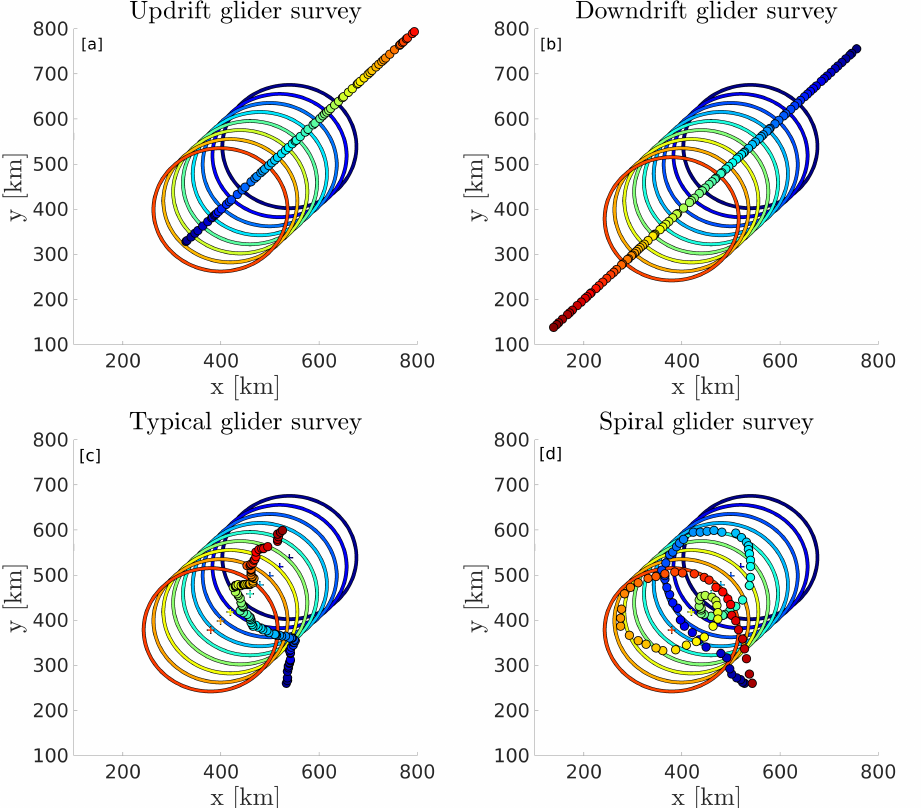
Figure 5. Successive positions of the drifting eddy’s edge (contours) superimposed on the simulated glider tracks (dots). Time is color coded and ranges between 0 (dark blue) and 20 (red) days. The center of the eddy is shown by the colored crosses. Panel ( a ) shows the updrift survey, panel ( b ) the downdrift survey, panel ( c ) shows a typical manually piloted survey, and panel ( d ) a spiraling survey.